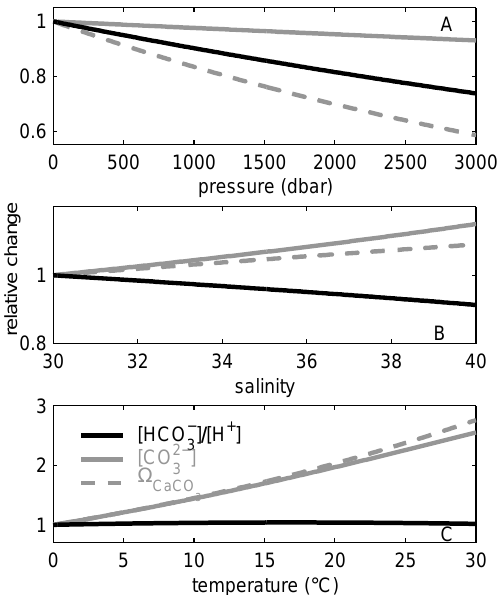
Figure 4. Relative change in [CO 2 − on (a) a pressure gradient, (b) a temperature gradient, and (c) a salinity